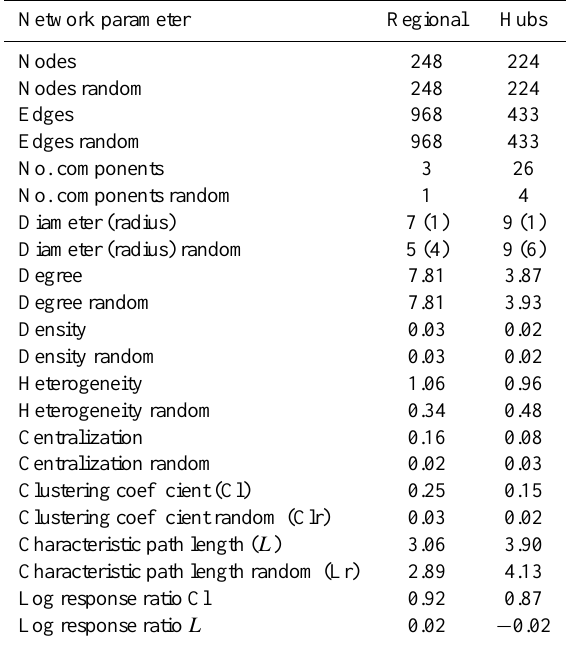
Table 4. Topology of the thermokarst systems co-occurrence net- works. Regional corresponds to a network built around the selected 294 OTUs whereas Hubs refers to a network where the most con- nected 24 OTUs from the whole network (Fig. S5a) were removed prior to this analysis. Random refers to topology characteristics of Erd˝os–Rényi random networks of similar